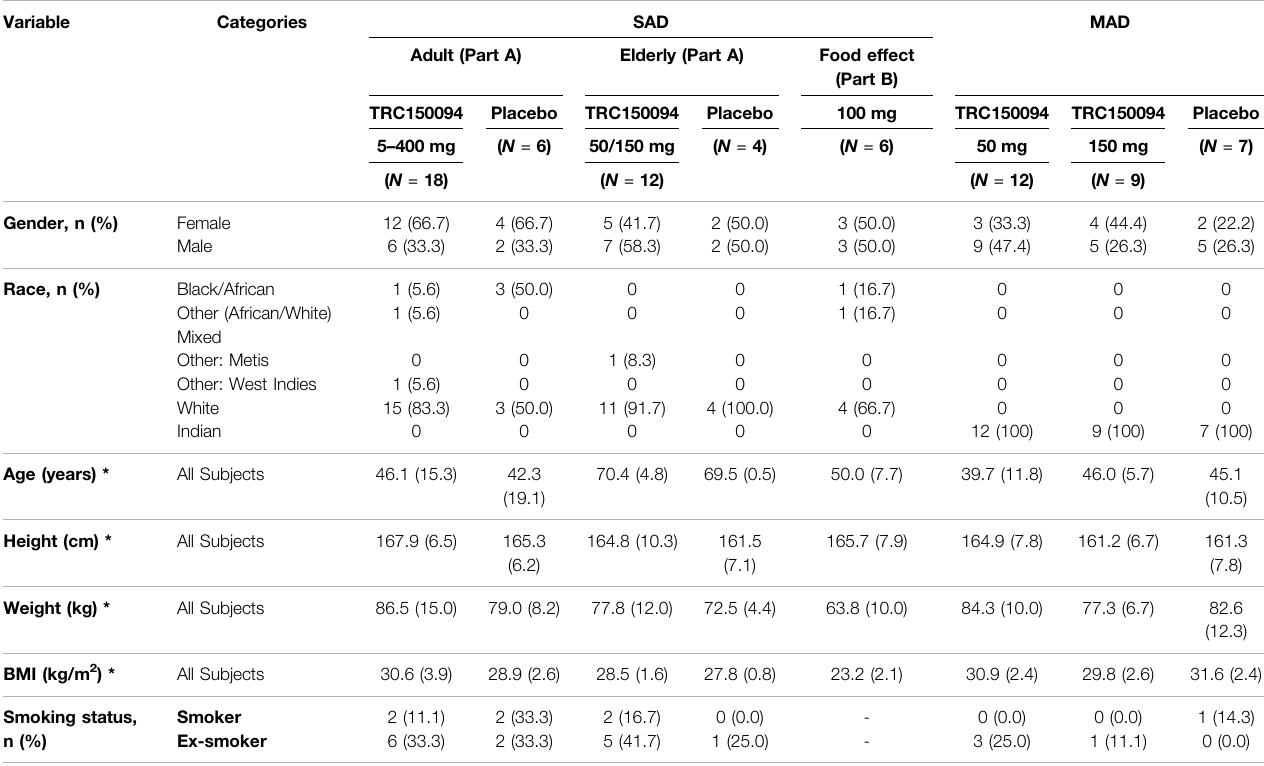
TABLE 2 | Demography and baseline